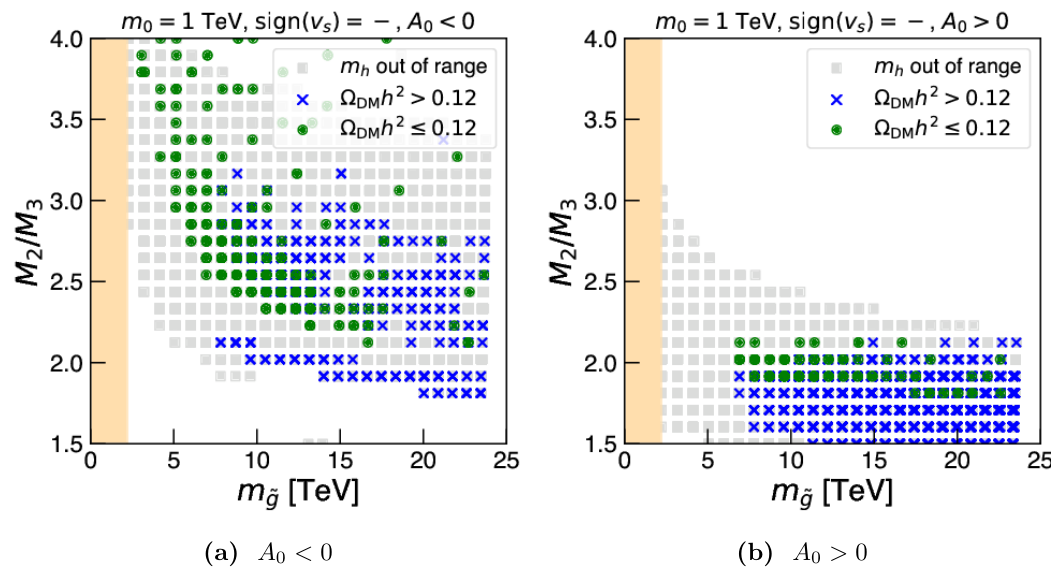
Figure 4. Scatter plots in the m - M 2 =M 3 plane. The meaning of the marks and the choice of m 0 e g and sign( v s ) are the same as in (cid:12)gure 3. The orange shaded region represents the current ATLAS & 2 : 2 TeV [114] for the LSP lighter than (cid:24) 1 bound on the gluino mass, m e g